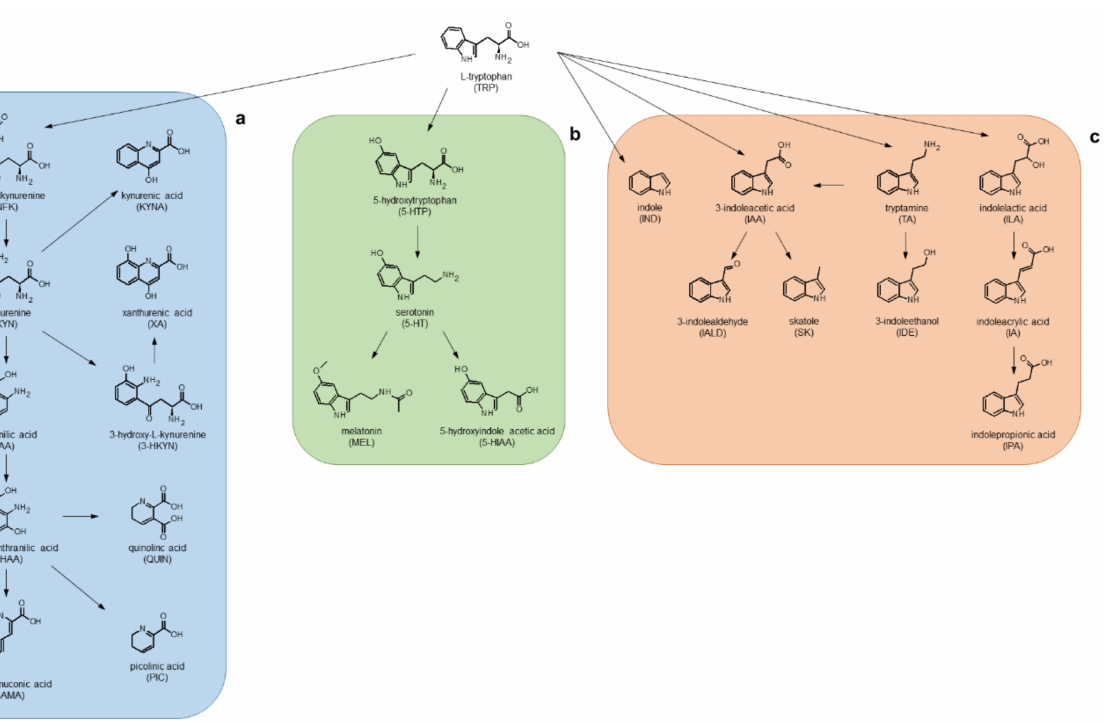
Figure 1. Schematic illustration of TRP metabolism through the ( a ) KYN and ( b ) 5-HT pathways, and ( c ) gut TRP